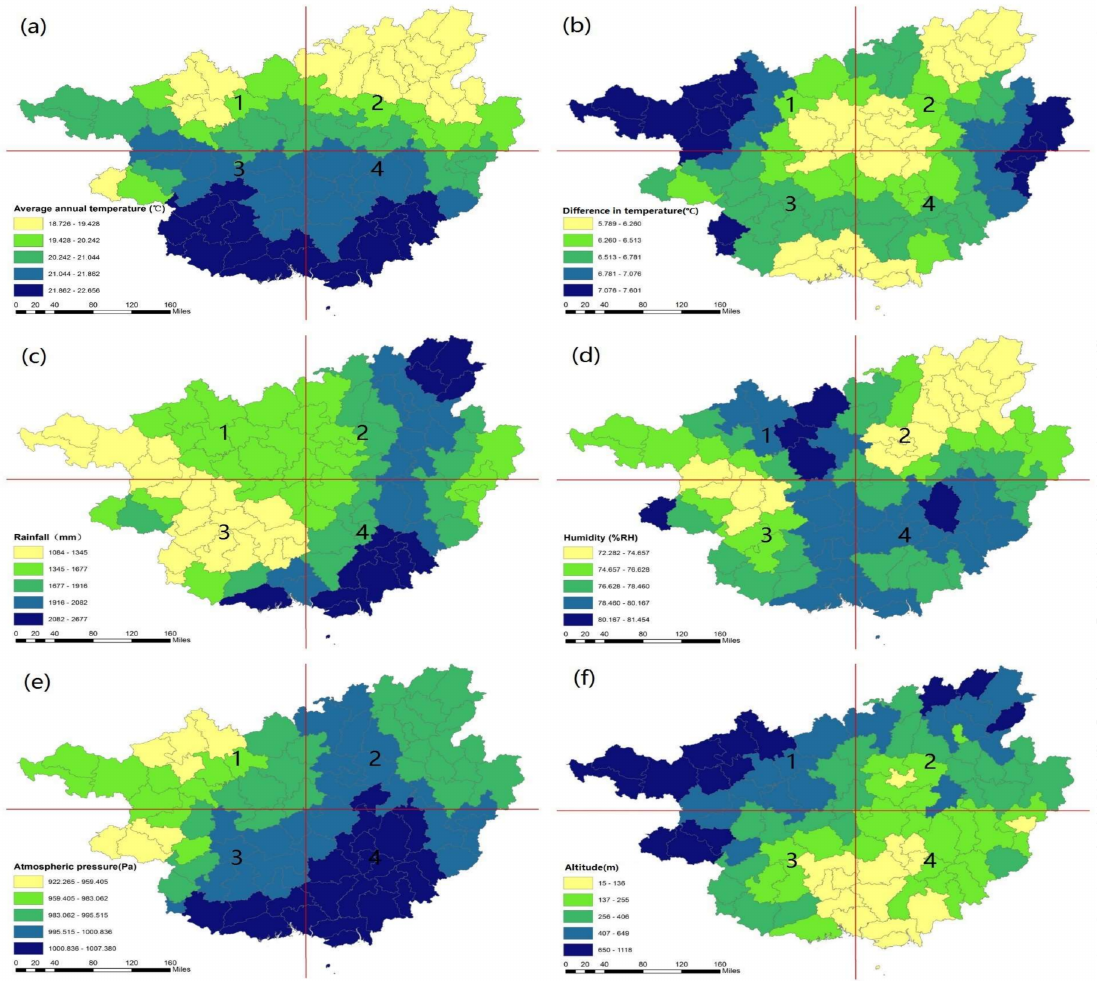
Figure 4. The spatial distribution of climate indicators in Guangxi ( a – f